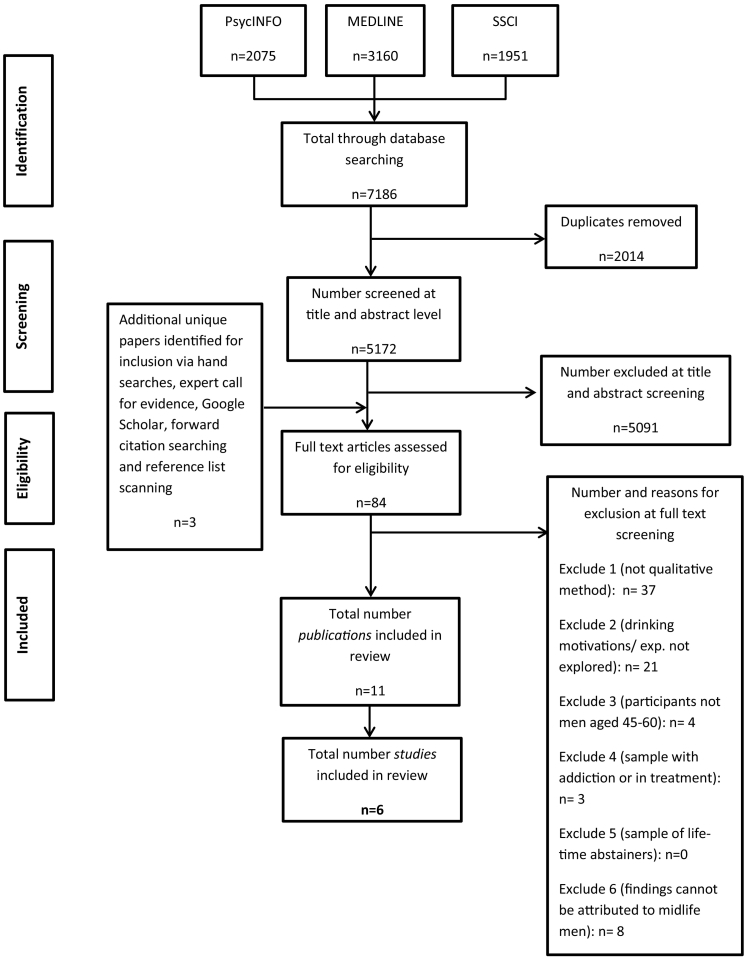
PRISMA flow chart.